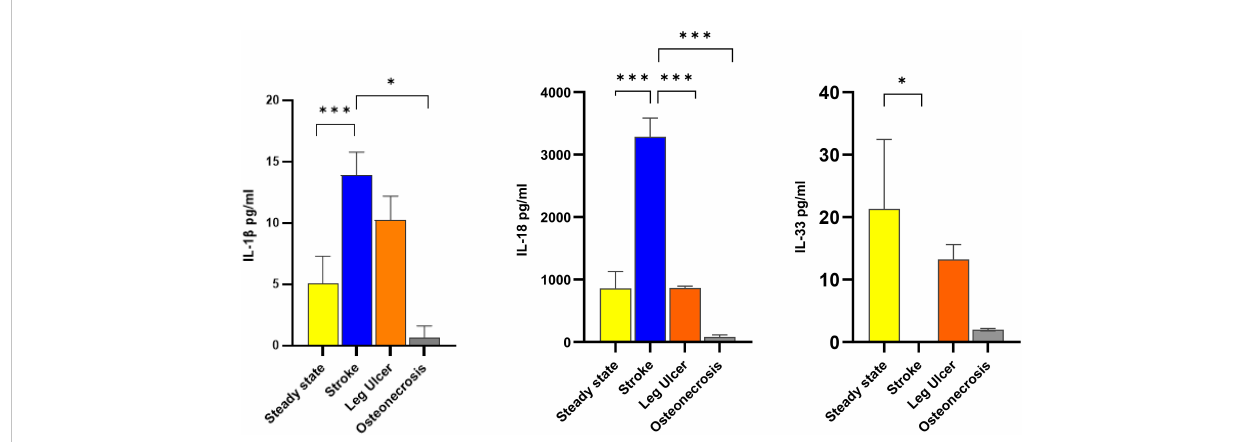
FIGURE 2 Comparison of IL-1 cytokine levels according to the 3 most common complications Cytokines levels were assessed in steady state SCD patients (34 patients; yellow columns), in crisis patients with stroke (17 patients; blue columns), in leg ulcers (10 patients; orange columns) and in osteonecrosis (4 patients; grey columns). Data are presented as mean pg/ml ± SD of IL-1 b (left panel), IL-18 (center panel) and IL-33 (right panel). Statistical signi fi cances for complications vs. steady state were found for IL-1 b (stroke vs. steady state, stroke vs. osteonecrosis), IL-18 (steady state vs. stroke, stroke vs. leg ulcer, stroke vs. osteonecrosis) and IL-33 (steady state vs stroke.). * p<0.05; ***